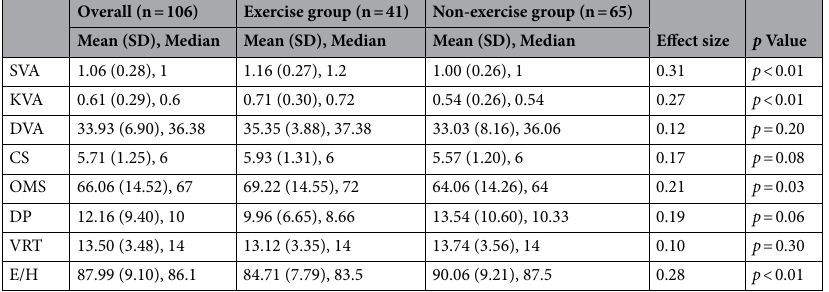
Table 1. Basic statistics and Wilcoxon test results for all sports vision tests. Abbreviations: SVA: static visual acuity, KVA: kinetic visual acuity, DVA: dynamic visual acuity, CS: contrast sensitivity, OMS: ocular motor skill, DP: depth perception, VRT: visual reaction time, E/H: eye/hand coordination, SD: standard deviation.